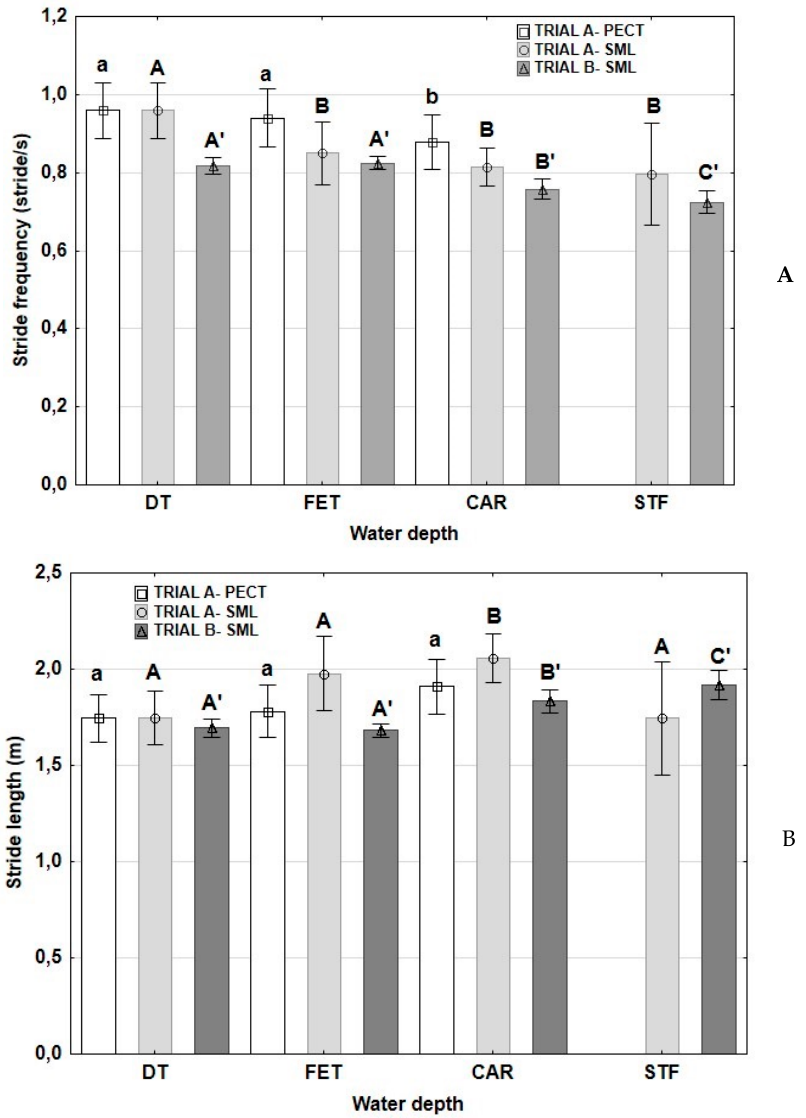
Figure 4. Means and standard deviations (whiskers) of stride frequency ( A ) and length ( B ) in horses exercised on a water treadmill at different water depths and velocities. DT: dry treadmill, without water; FET: water at the level of the fetlock; CAR: water at the level of the CAR; STF: water at the level of the stifle. Trial A-PECT: accelerometer fixed in the pectoral region with velocities of 6 km/h; Trial A-SML: accelerometer fixed in the sacrum midline at velocities of 6 km/h with the water at DT, FET and CAR and at a velocity of 5 km/h with the water at STF; Trial B-SML: accelerometer fixed in the sacrum midline at a velocity of 5 km/h in the four water depths. Lowercase letters: significant differences between water depths in trial A-PECT; capital letters: significant differences between water depths in trial A-SML; capital letters with apostrophes: significant differences between water depths in trial B-SML. Different letters indicate significant differences between water depths at each trial p < 0.05.